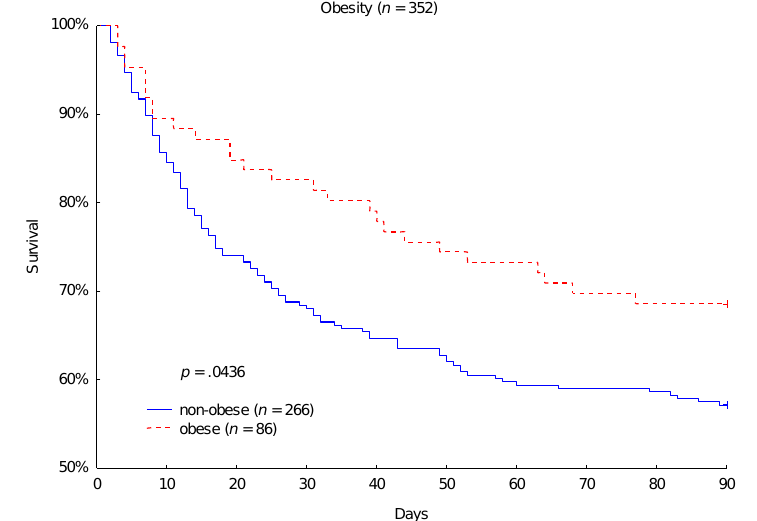
Figure 1. Kaplan-Meier 90-day mortality analysis with respect to obesity category.